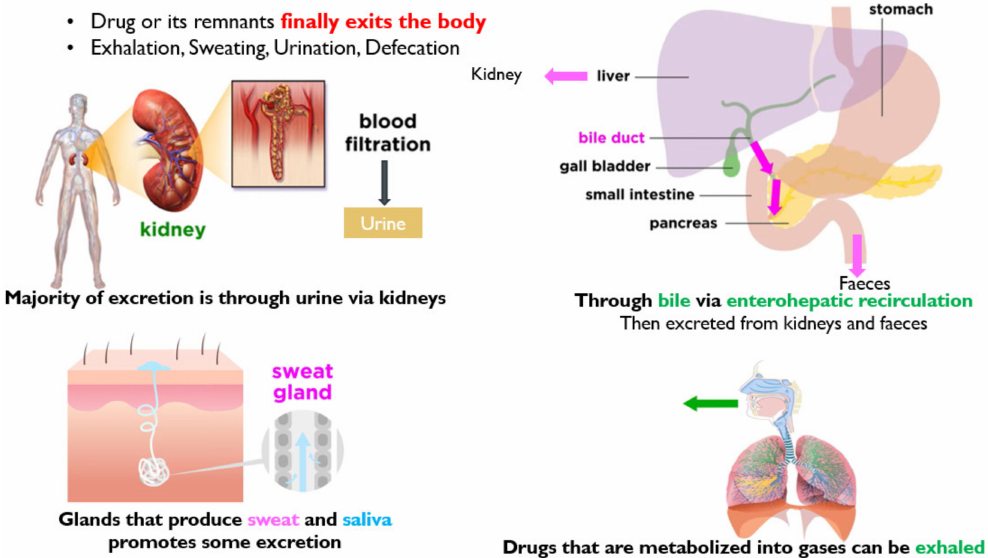
Figure 14. Schematic illustration of drug excretion from the body by kidneys, liver, skin and airways.